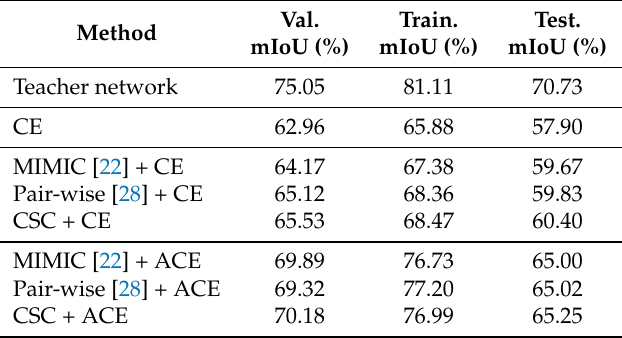
Table 7. Comparison of different distillation methods on the Camvid dataset. CE is the method using the conventional cross-entropy loss function without distillation. CSC is the method using the proposed CSC loss function. ACE is the method using the proposed ACE loss